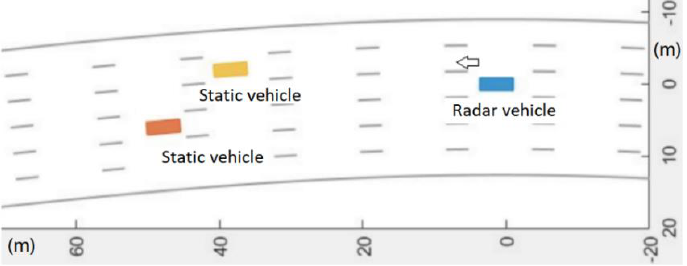
Figure 15. Schematic diagram of ground clutter scene.